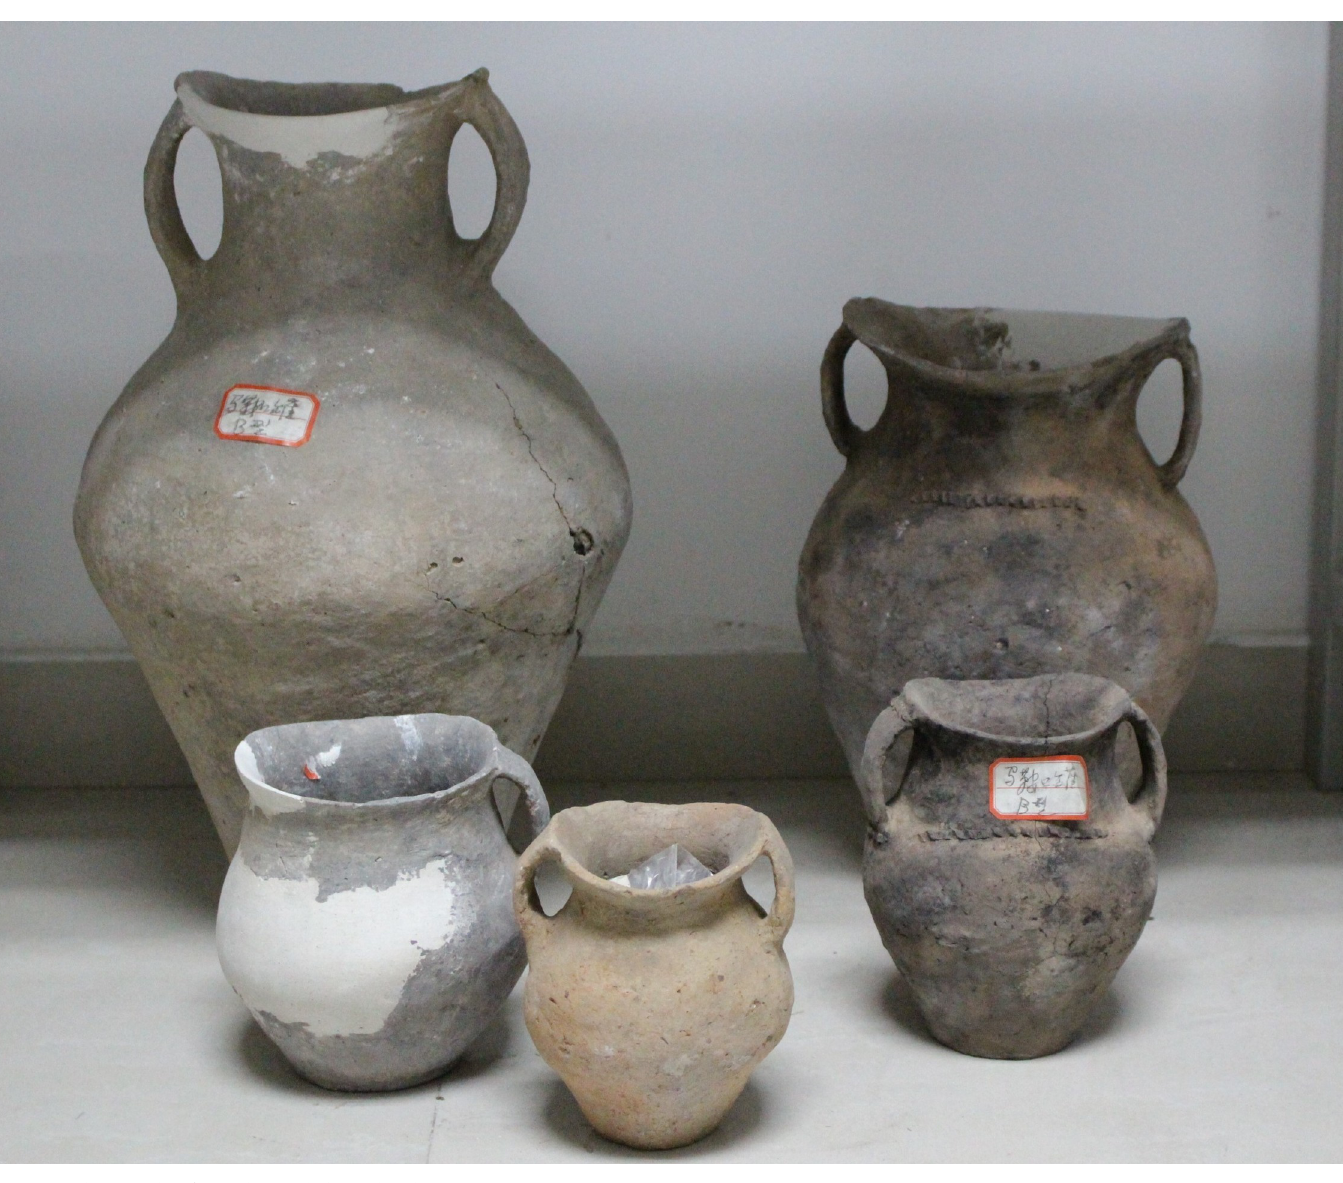
Fig 2. A selection of ma’an style vessels from the Zhanqi